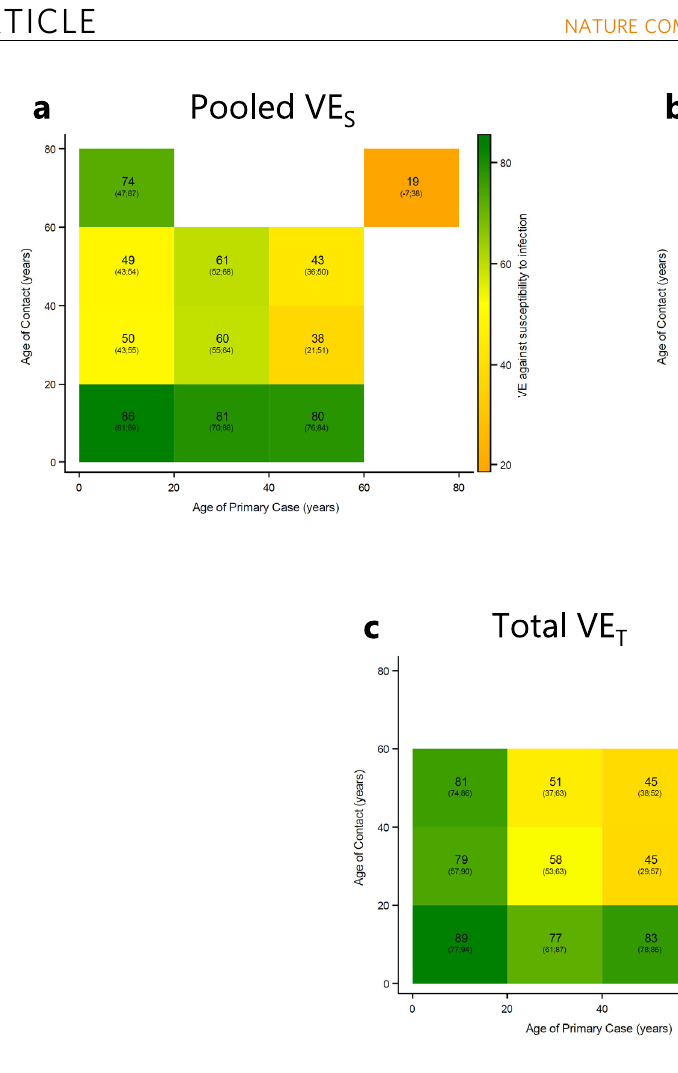
Fig. 1 Crude VE estimates (%), strati fi ed by age of the primary case and contact. This fi gure shows crude VE estimates strati fi ed by age of the primary case and contacts. a Shows the pooled VE S . b Shows the pooled VE I . c Shows the total effect, VE T . 95% con fi dence intervals clustered on the household level in parentheses. SAR strati fi ed by age and vaccination status of both primary cases and contacts are presented in Fig.